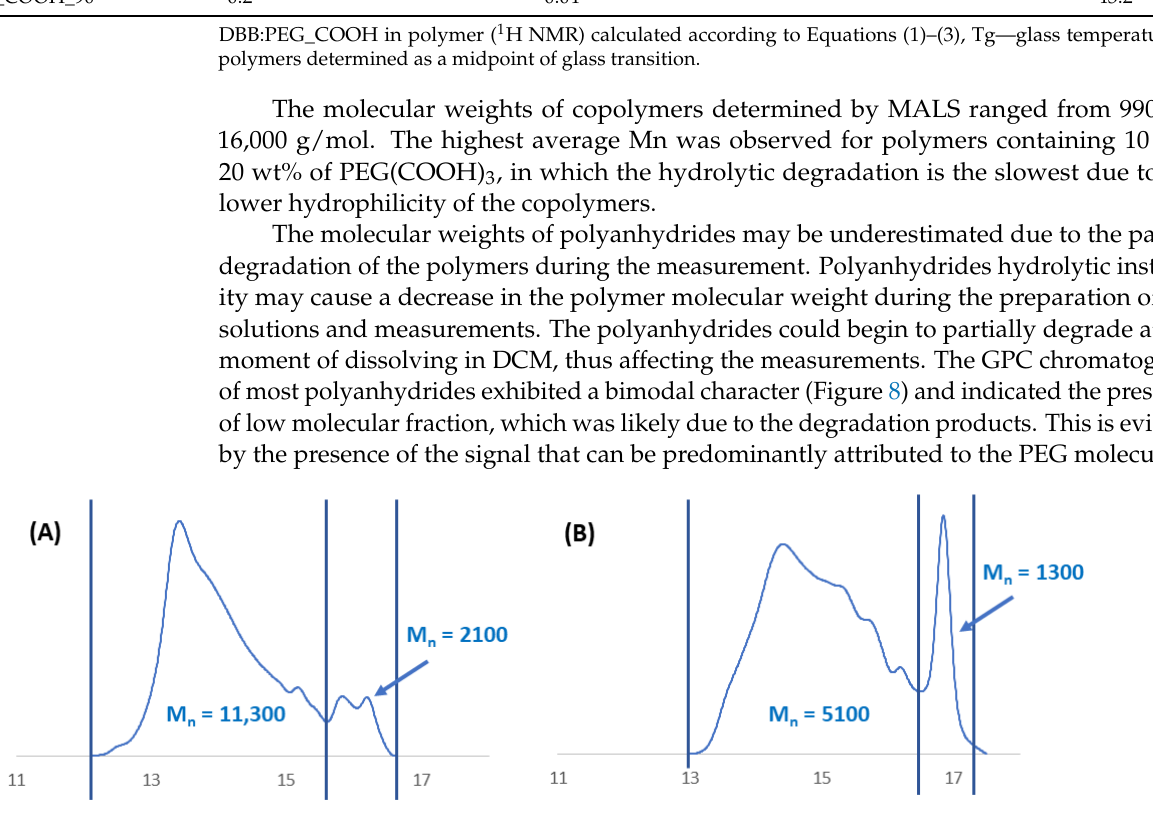
Figure 8. Gel-permeation chromatography (GPC) chromatograms of polyDBB_PEG_COOH_30 ( A ) and polyDBB_PEG_COOH_60 ( B ).